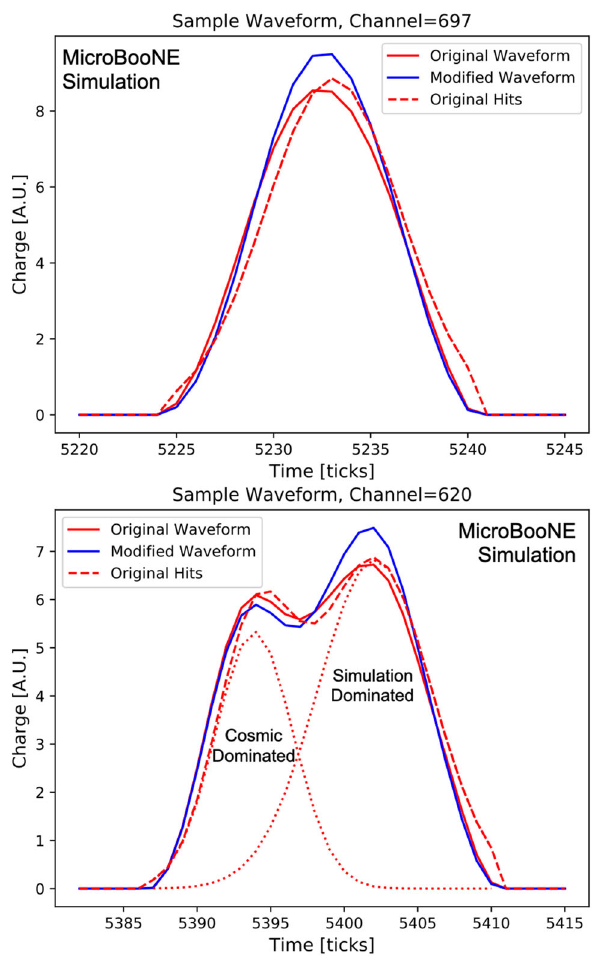
Fig. 10 Examples of modified waveforms. The top graph shows a sim- ple example where the wire signal region is well-described by a single Gaussian function. The bottom graph shows a case where one portion of the waveform is associated to simulated charge while the other is associated with cosmic data charge. Here, the simulation-dominated portion of the waveform is modified but the cosmic-dominated portion is